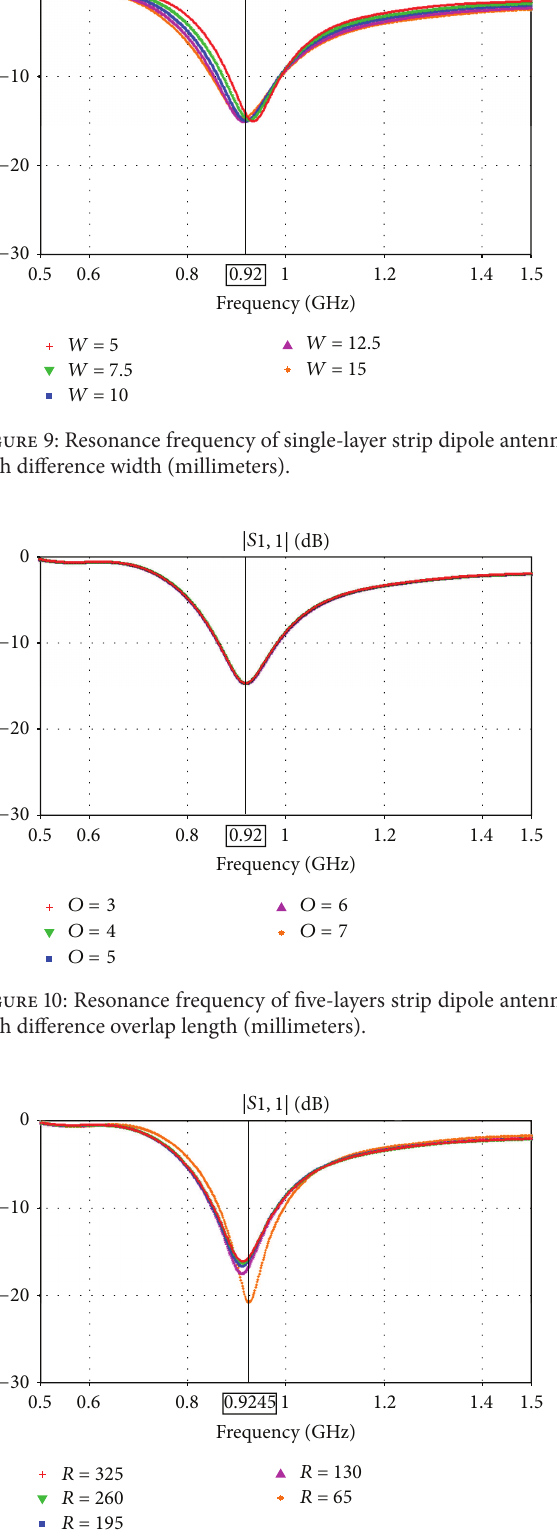
Figure 14: Resonance frequency of four-layers strip dipole antenna with difference curving radius